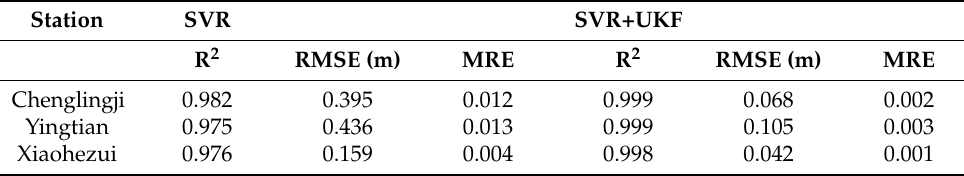
Table 3. Performance comparisons between SVR and SVR+UKF.